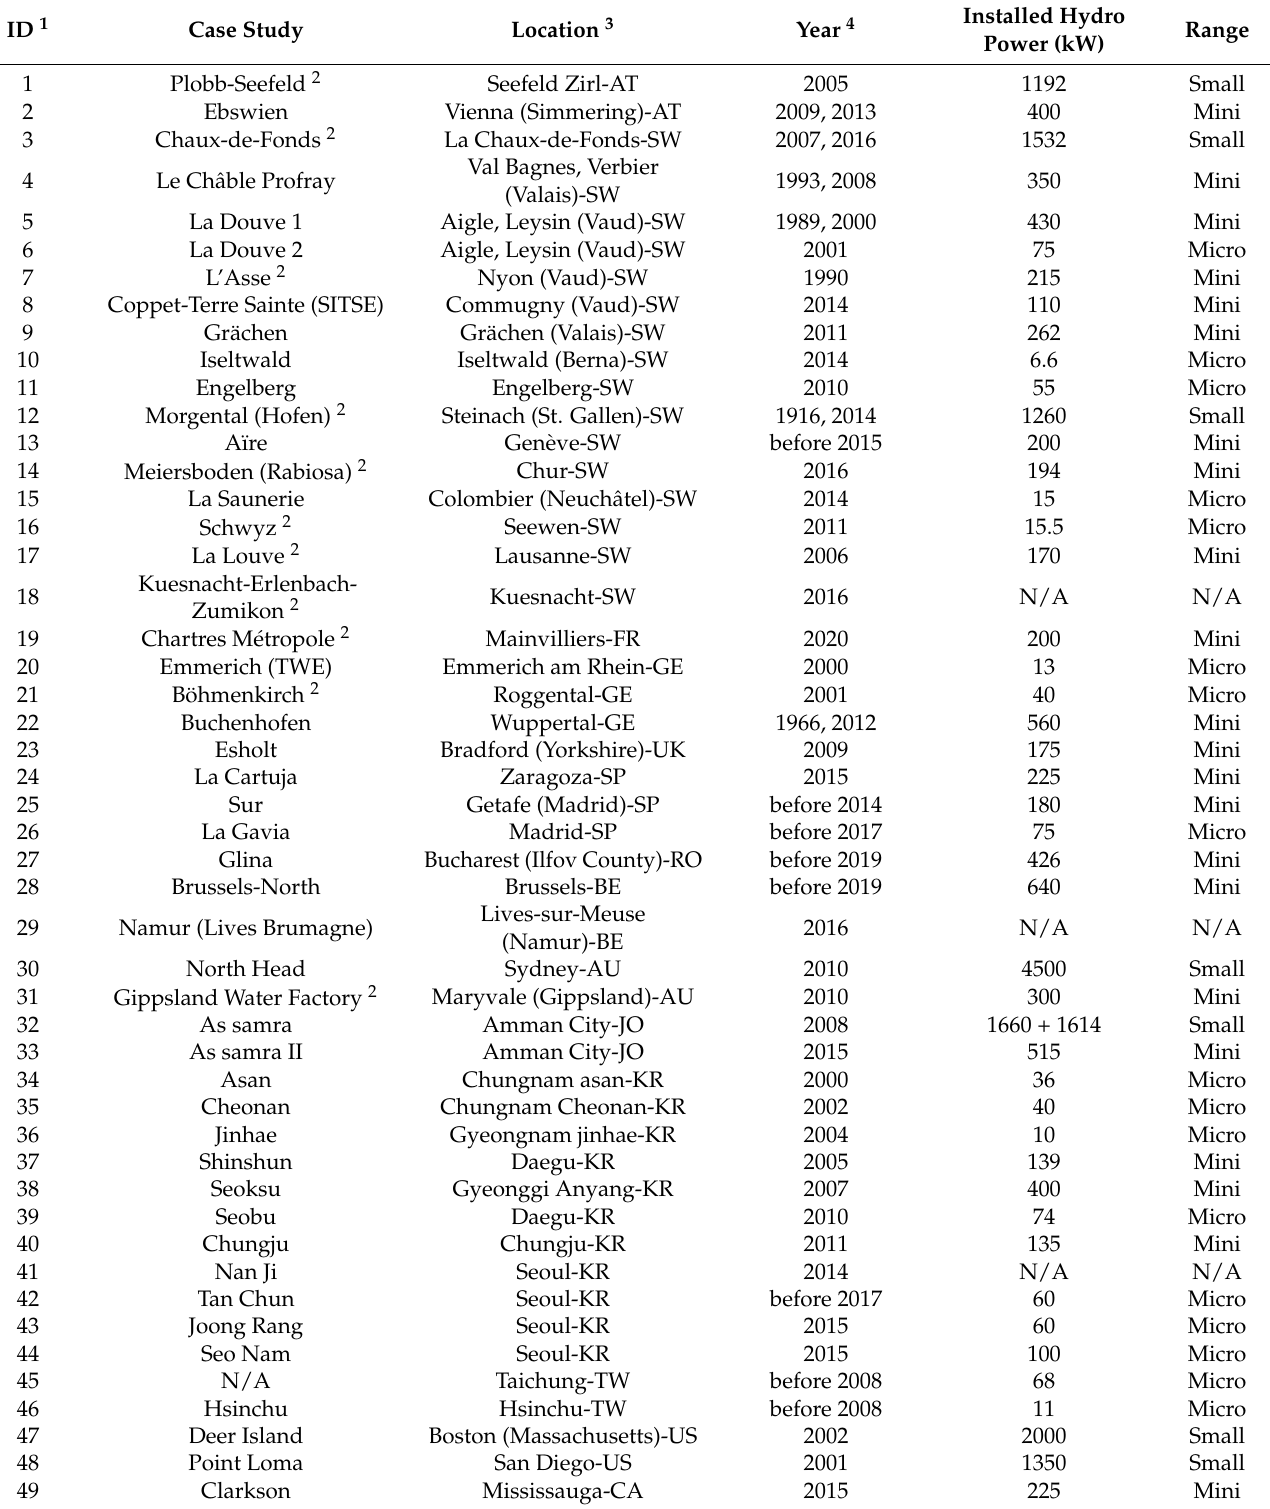
Table 2. Inventory of the 49 real cases studies of hydropower application to wastewater systems found during this